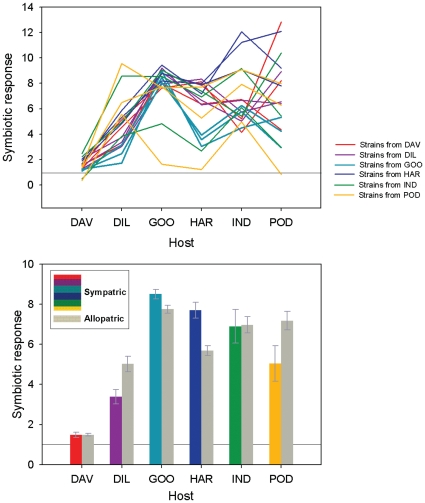
Host growth responses to sympatric and allopatric rhizobial strains.(a) The symbiotic response of six host plants to rhizobial strains originally collected from a given host species and tested with all hosts. The three strains collected from the same host are depicted with the same colour and the colours correspond to those in Fig. 4b. (b) The symbiotic response of hosts to the same rhizobial strains grouped as sympatric (originally collected from the same host species), and allopatric (strains originally collected from other hosts species). Error bars are based on standard errors of means. In both (a) and (b) the solid line at 1 on the y-axis indicates the level where the host did not gain or lose anything from the rhizobial interaction relative to the N− control treatment. Host species abbreviations are as in Fig. 1.